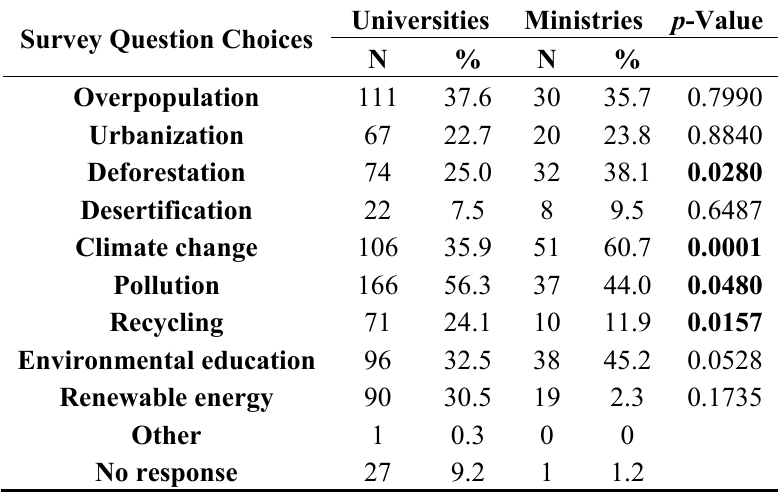
Table 7. Response to “top three environmental issues in